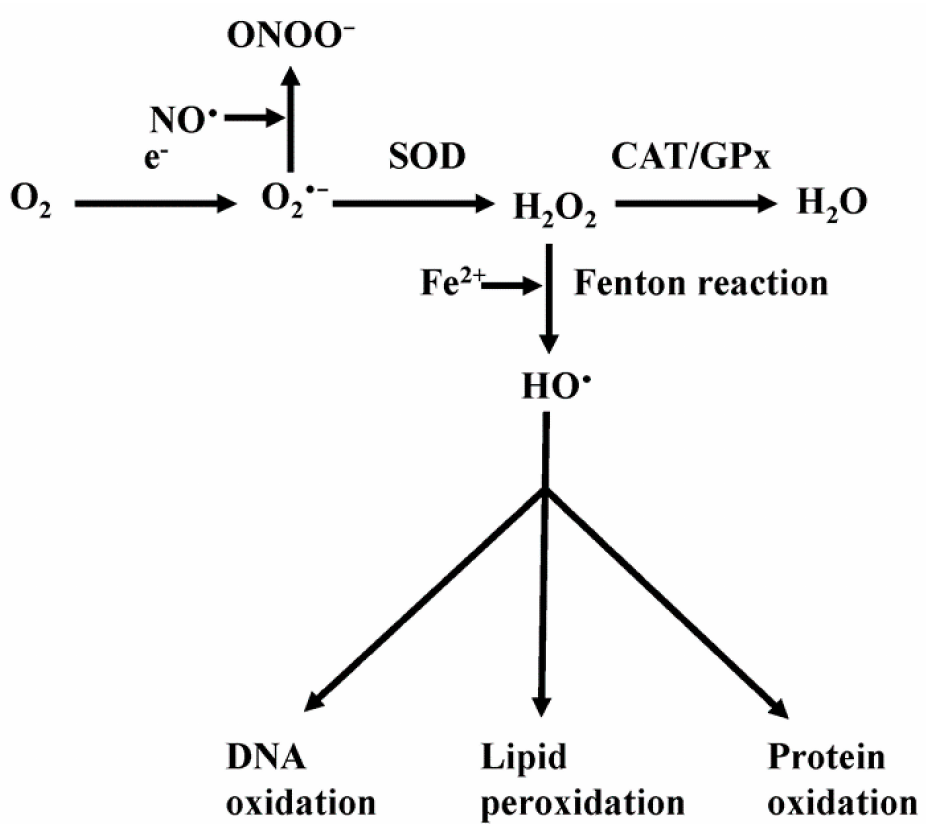
Figure 2. Reactive oxygen species production and toxicity. Oxygen accepts an electron to